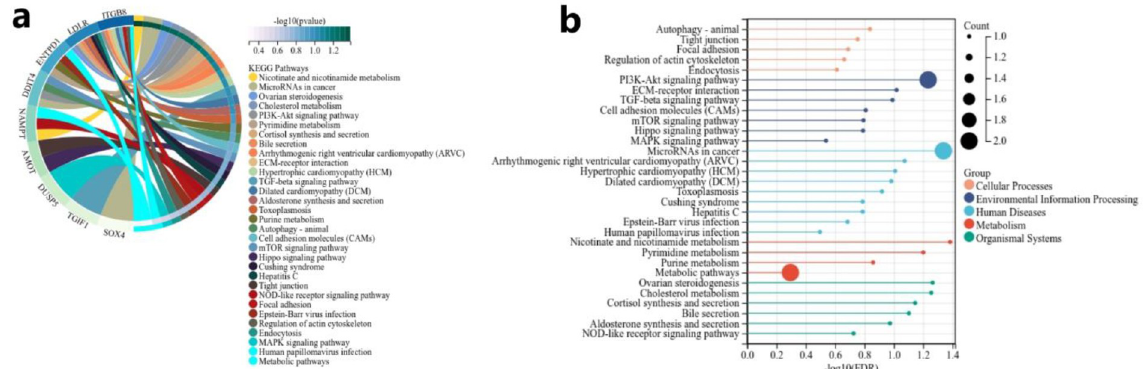
Fig 7. Result of KEGG pathway enrichment analysis. (a)a total of 31 KEGG pathway were enriched by 9 mRNA. (b)Bar chart of the result.